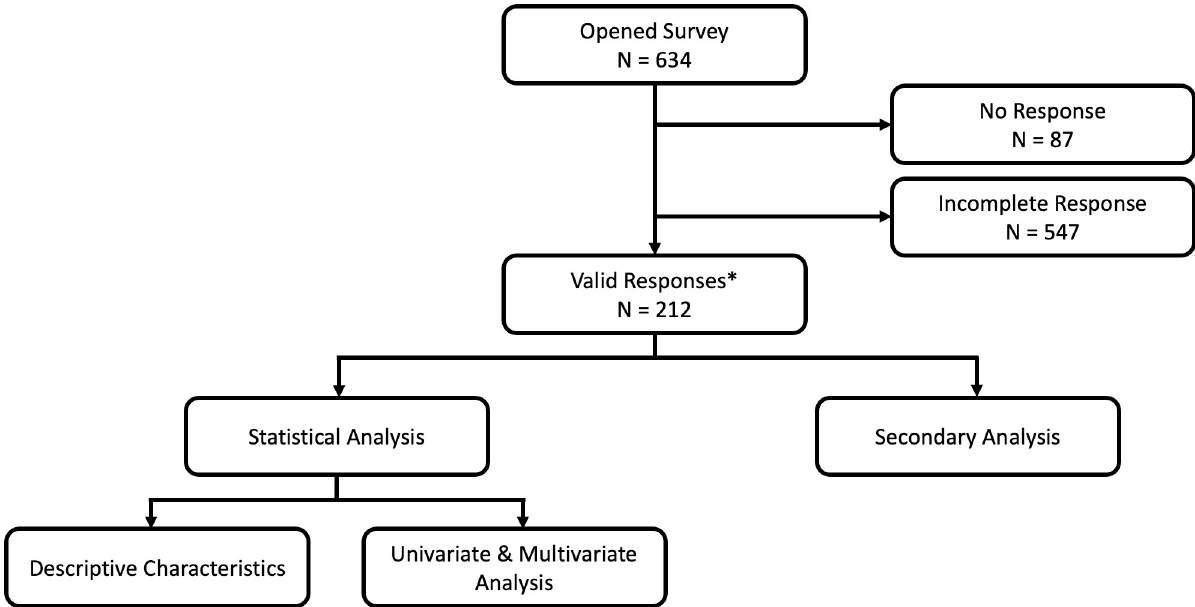
Fig 1. Participant flow chart. Participation by medical students in the survey. � A valid response constituted completing all demographics questions and all questions in our logistic regression.